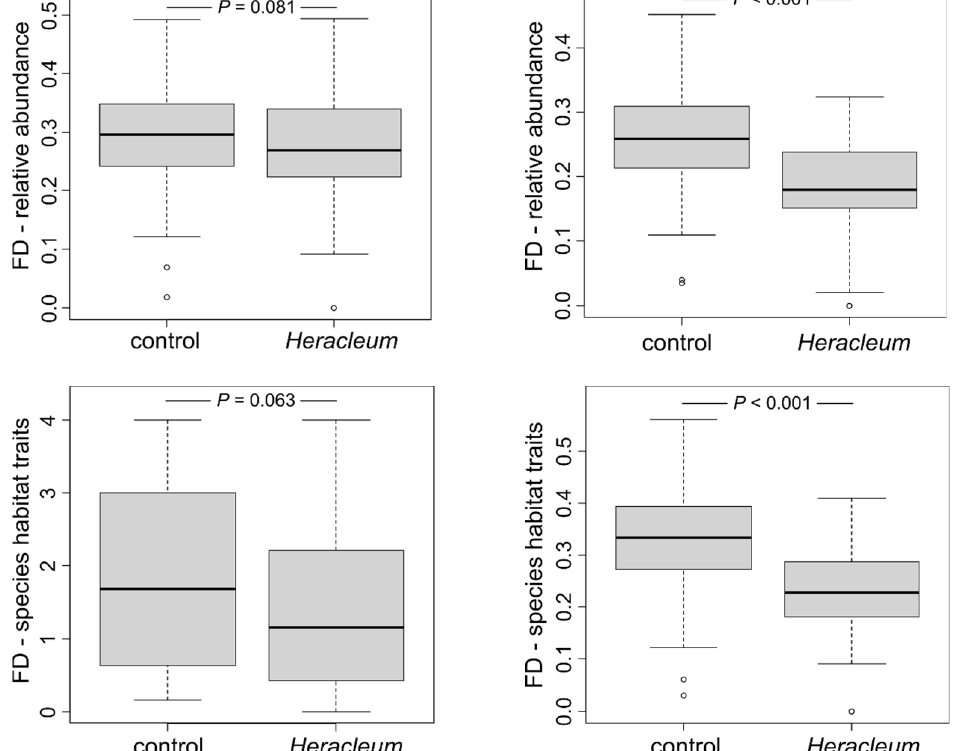
Figure 6. Boxplots showing differences in diversities between control and Heracleum sites (N = 38) in forest birds (left side) and non-forest birds (right side); FD—functional diversity.